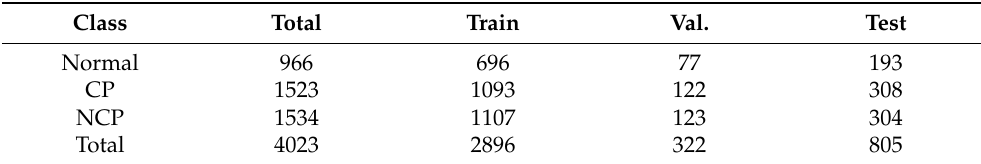
Table 3. The number of chest CT scans used for the training set, validation set and test set for patients without lung lesions (i.e., Normal), with common pneumonia (i.e., CP) and with novel coronavirus pneumonia (i.e., NCP). The last row reports the overall size of the dataset. Class Total Train Val. Test Normal